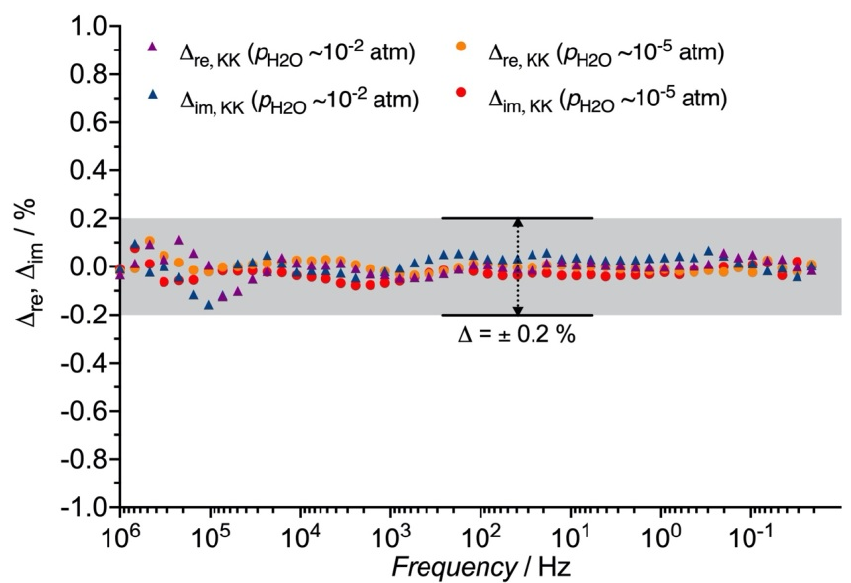
Figure 4. Residual plots obtained for the Kramers-Kronig (KK) relations from the electrochemical impedance spectroscopy (EIS) dispersion at 450 °C in both wet ( p H2O ~ 10 − 2 atm) and low humidity ( p H2O ~ 10 − 5 atm) O 2 atmosphere.